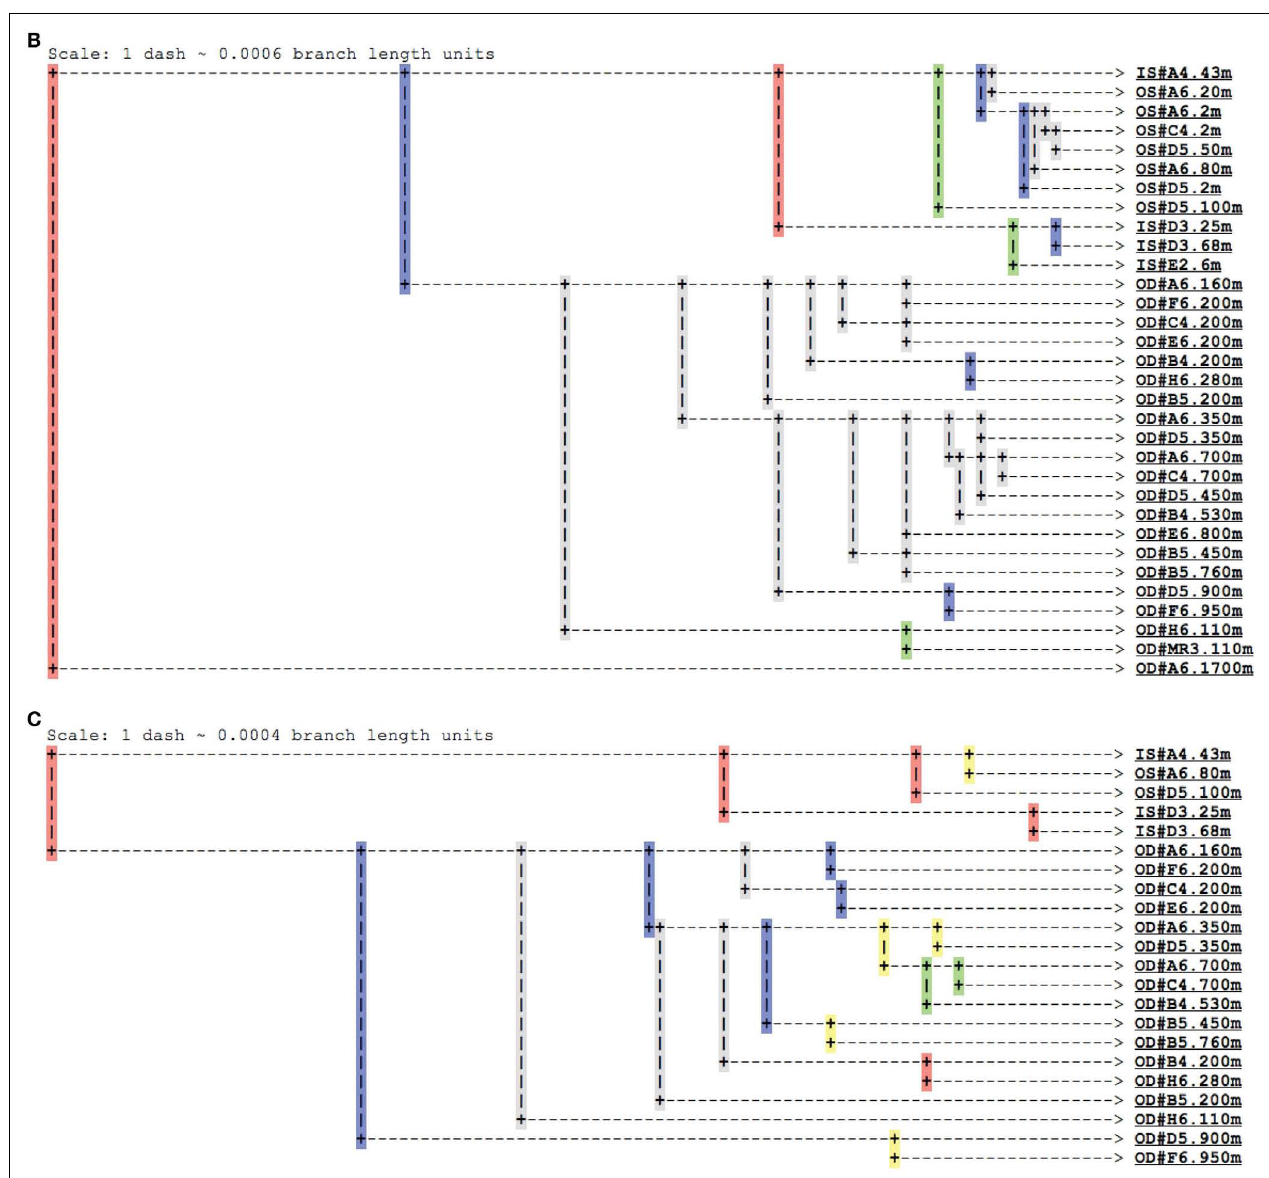
indicate the percentage of iterations supporting a given node – red ( > 99.9%), yellow (90–99.9%), green (70–90%), blue (50–70%), or gray ( < 50%). Sample groups are indicated as: IS# = inshore, near-surface; OS# = offshore, near-surface; OD# = offshore, deep; with # indicating the sample as